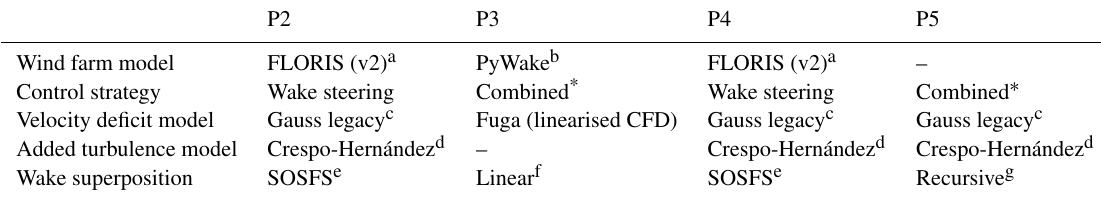
Table 2. Overview of participating models. P2 P3